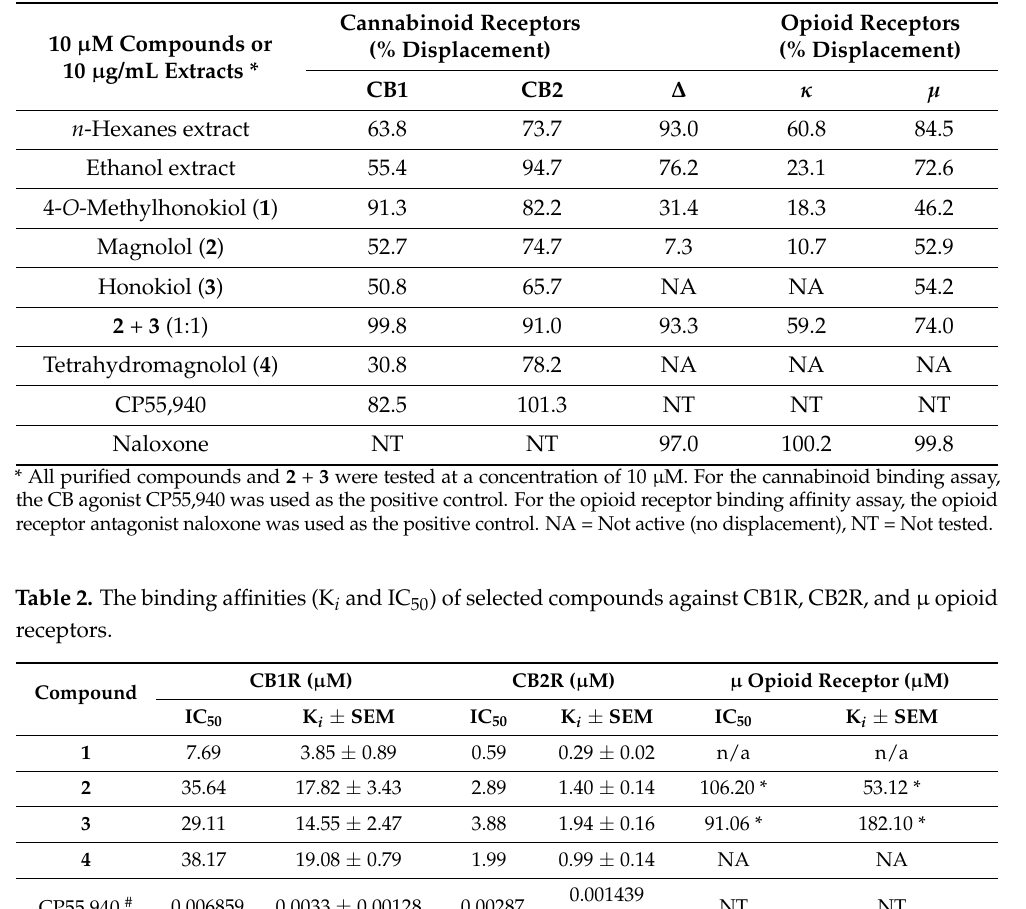
Table 1. The binding affinities of extracts/compounds towards human cannabinoids and opioid receptors.